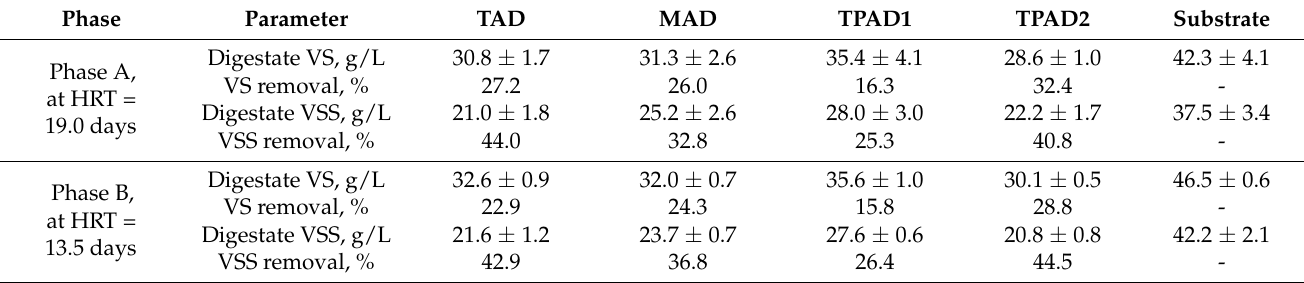
Footnote 1. VS and VSS removal in TPAD2 column express the total efficiency of the TPAD process. Footnote2. VS—volatile solids; VSS—volatile suspended solids; TAD—thermophilic anaerobic digestion; MAD—mesophilic anaerobic digestion; TPAD—temperature- phased anaerobic digestion; TPAD1—the first stage of TPAD; TPAD2—the second stage of TPAD; HRT—hydraulic retention